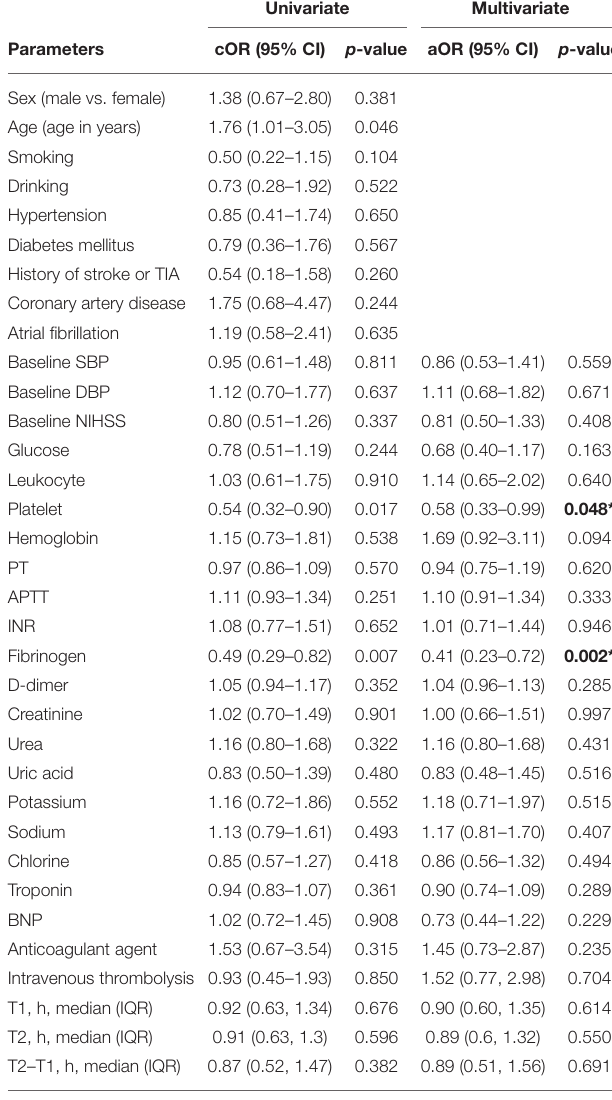
TABLE 2 | Comparison of the baseline characteristics and clinical outcome according to the subcategorized groups of HT. Characteristics